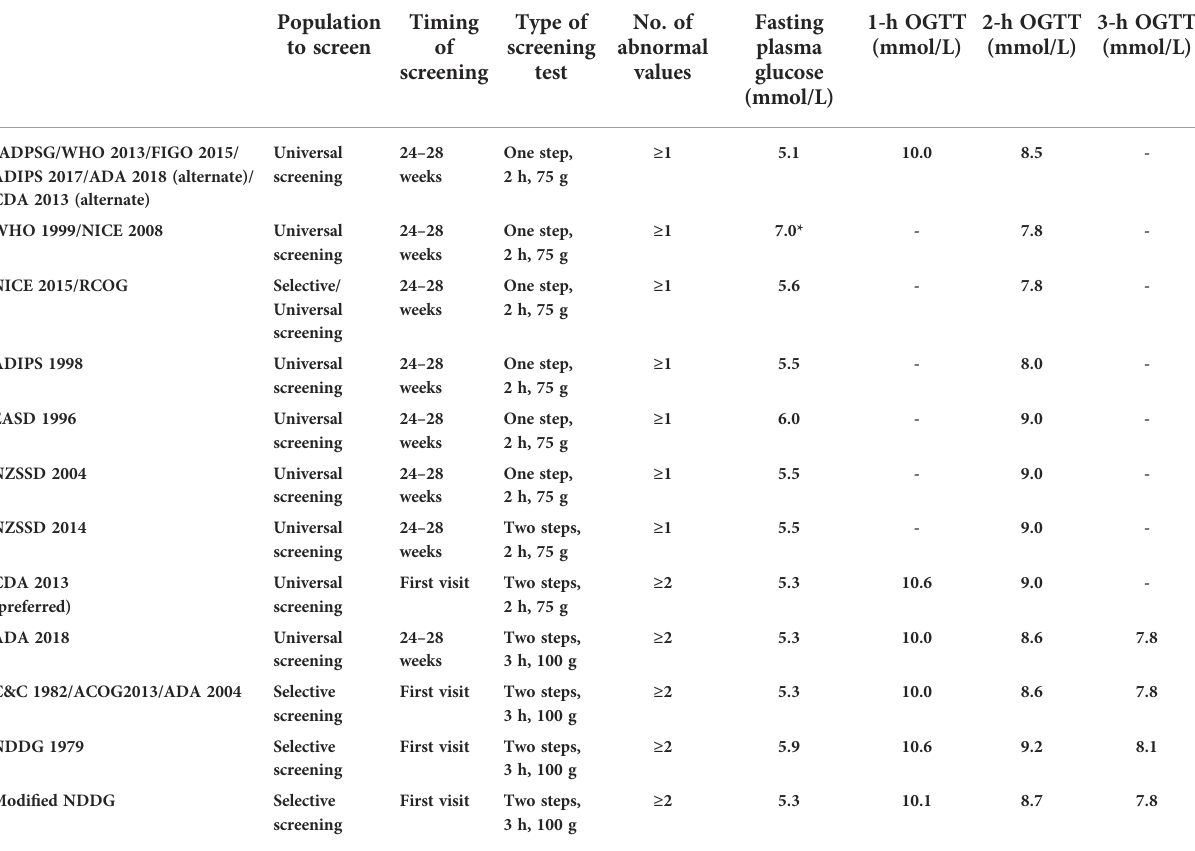
TABLE 1 GDM screening and diagnostic